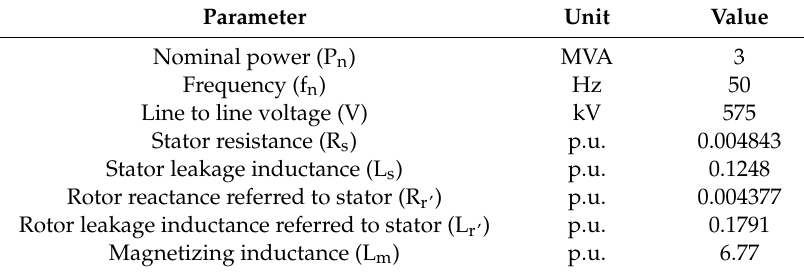
Table A2. Generator